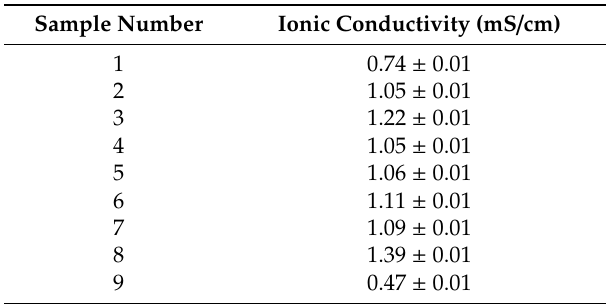
Table 2. Ionic conductivities of the glycerol / PEO GPE solutions (samples 1 to 8) and of the commercial liquid Man Solar electrolyte (sample 9). Samples were measured at 40 ◦